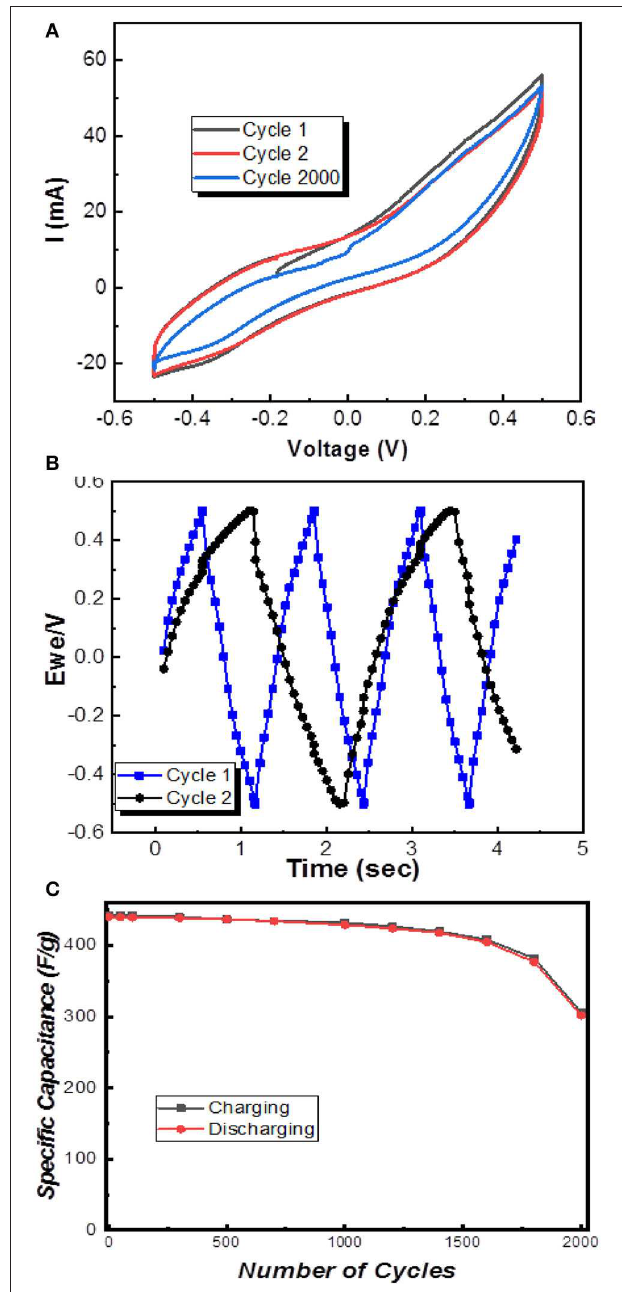
FIGURE 4 | (A) Specific capacitance of Nb-doped MXene, (B) Charge-discharge curves of efficient cycle 1 and 2, and (C) Specific capacitance vs. number of cycles.